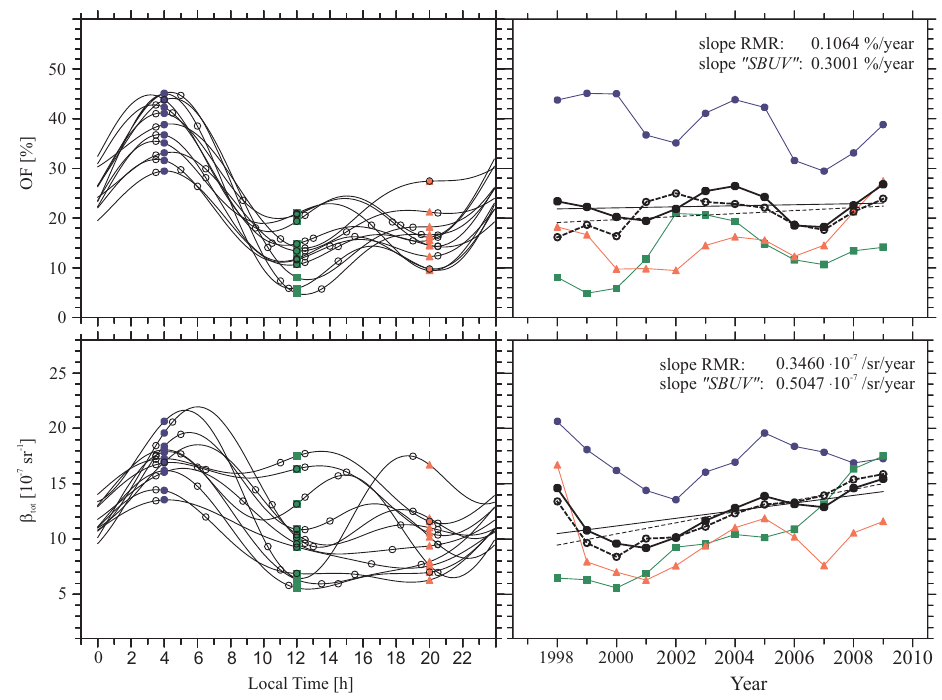
Fig. 11. Reconstructed local time and year-to-year variations of NLC occurrence (top) and brightness (bottom) for the ALOMAR RMR-lidar data set from 1997 to 2010. Left panels show the diurnal behavior for each year calculated from the harmonic fit coefficients (mean, 24-, 12-h) in Fig. 5 (black lines). ALOMAR overpasses of NOAA-satellites contributing to the SBUV time series between 1998 and 2009 are marked by open circles. Three single local times are marked by colored symbols. Right panels show the year-to-year behavior as calculated from the diurnal behavior for different local time filtering: all 24 local times = RMR-curve (black solid line and filled circles), NOAA local times = “SBUV” -curve (black dashed line and open circles), single local times (colored lines and symbols). Straight lines show the slopes of RMR- and “SBUV” -curves as determined by linear regression. Based on 3 years running means for clouds above the long-term limit. For more details see text. Correlation between seasonal mean NLC parameters, solar activity and temperature at 83km altitude for clouds above the long-term limit ( β max > 4). Numbers are for the whole time series and reduced data sets (in brackets): Lyman- α dependencies with- out 2005–2008, temperature dependencies without 1998. Units: occurrence [%], brightness [10 − 10 m − 1 sr − 1 ], altitude [km], Lyman- α [10 11 photonss − 1 cm − 1 ], temperature [K]. Lyman- α data are taken from http : //lasp.colorado.edu/lisird/lya/ . Temperatures are cal- culated by LIMA for times of lidar measurements. Slopes for the linear regressions are only given for significant correlations. X Y Corr. Coeff. Signif. Slope Lyman- α − 0 . 28 ( − 0 . 73) (95%) ( − 7 . 92)